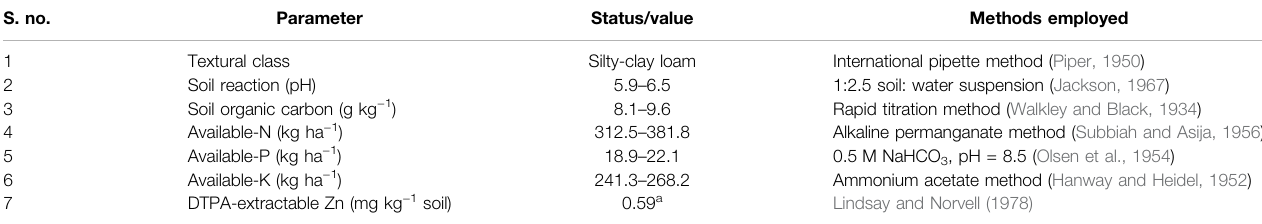
TABLE 1 | Physico-chemical properties of experimental soils at the initiation of fi eld experimentation in the wet-temperate northwestern Himalayas. S.